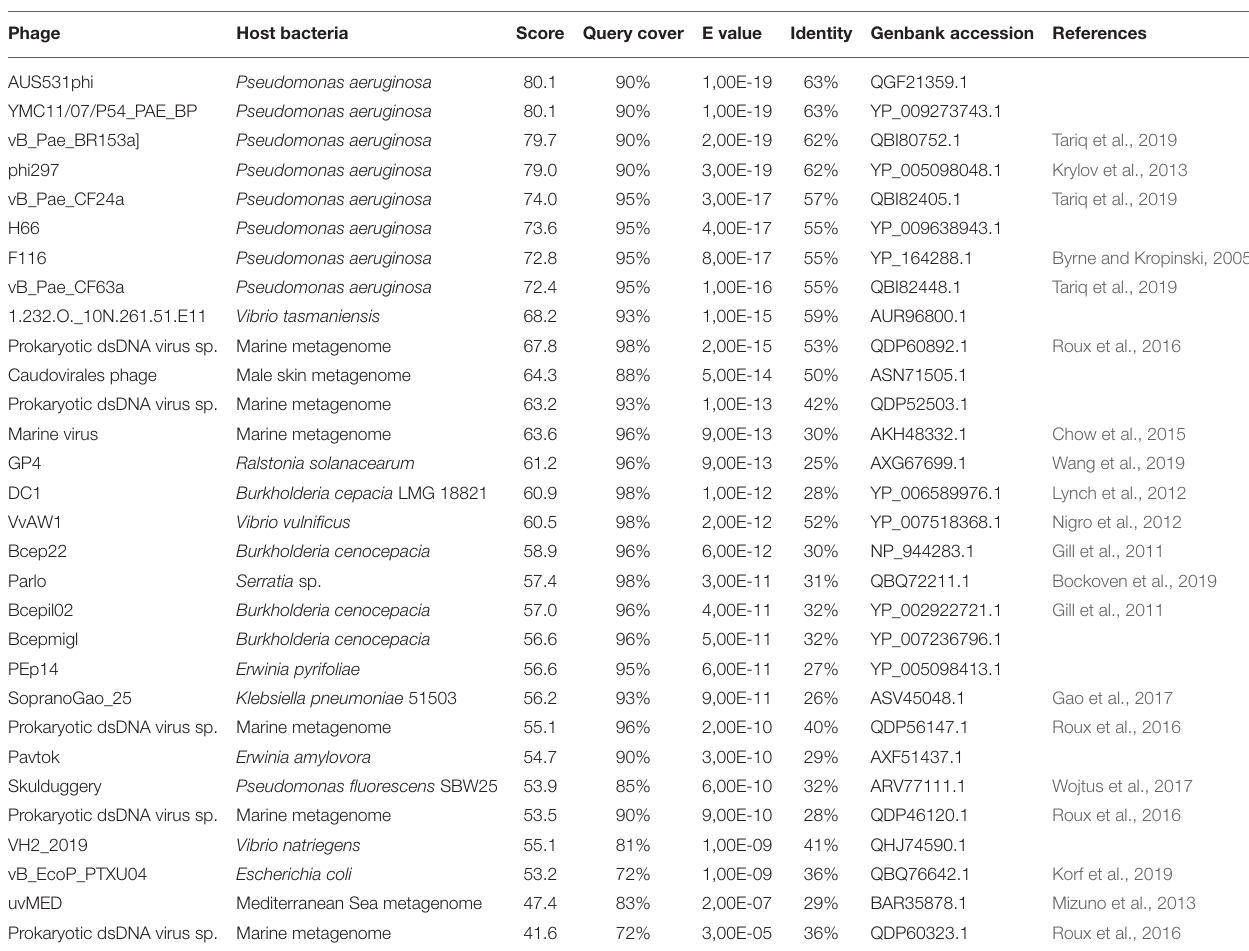
TABLE 3 | Csr homologs in bacterial